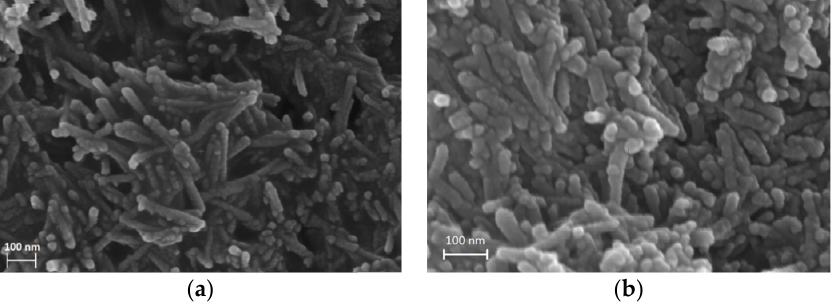
Figure 2. Field-emission scanning electron microscopy (FE-SEM) of ( a ) CeO 2 -NR and ( b ) PdO x /CeO 2 -NR.